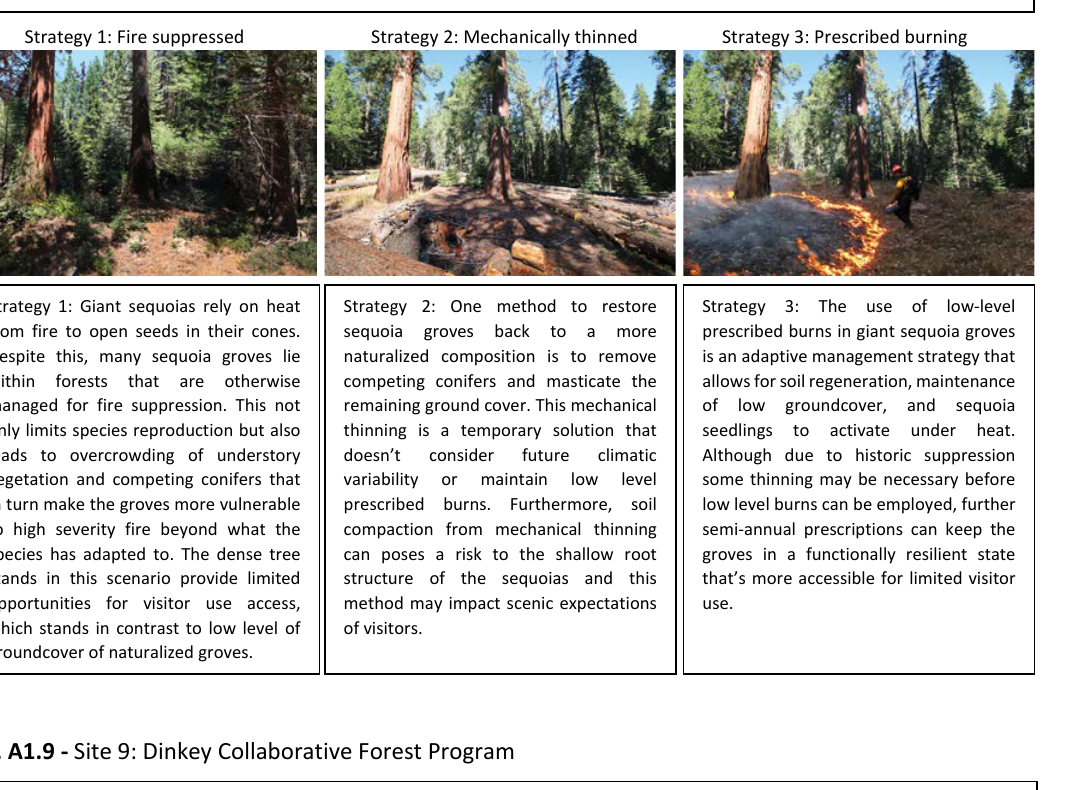
Fig. A1.8 - Site 8: Case Mountain Giant Sequoia Complex